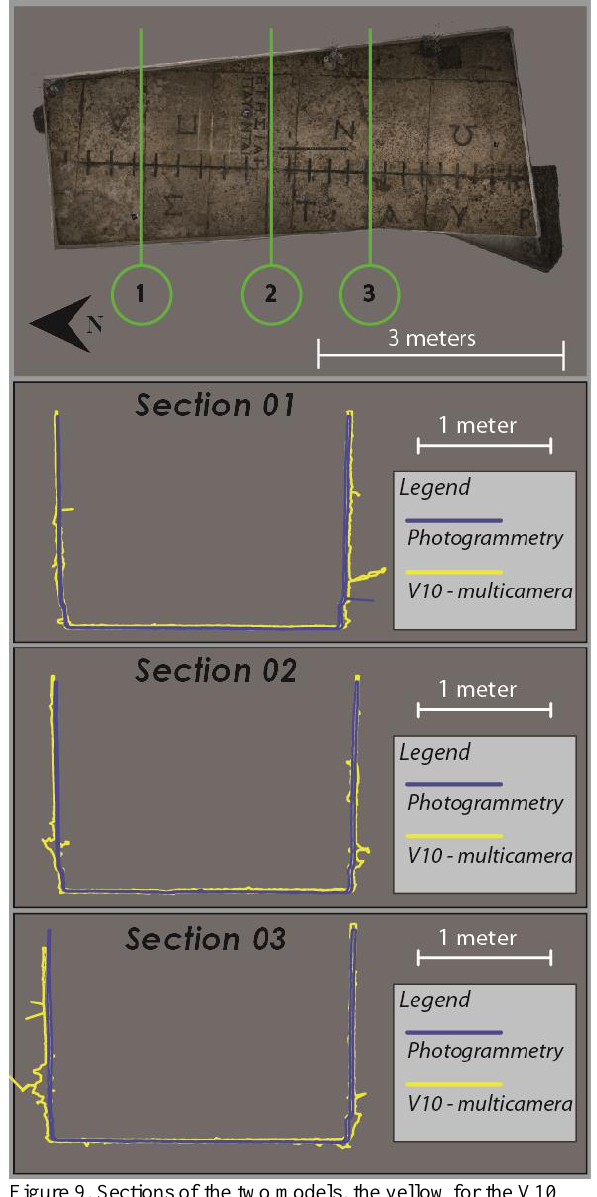
Figure 9. Sections of the two models, the yellow for the V10 model, the blue for photogrammetry